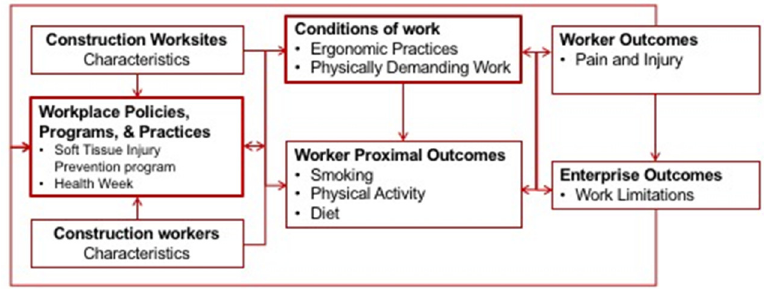
Figure 1. Logic model for the All the Right Moves (ARM) intervention.